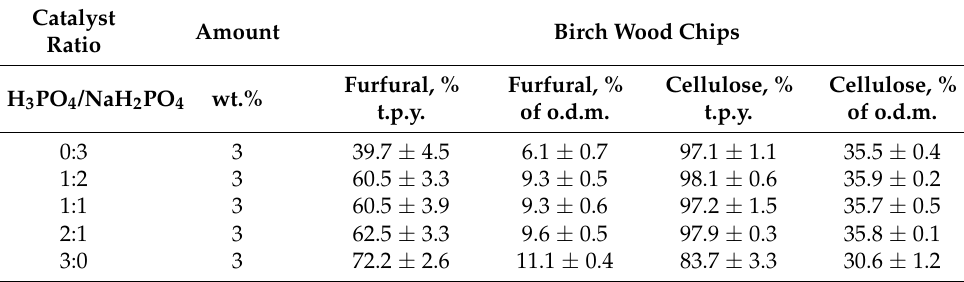
Table 2. Effect of H 3 PO 4 /NaH 2 PO 4 solution on the target